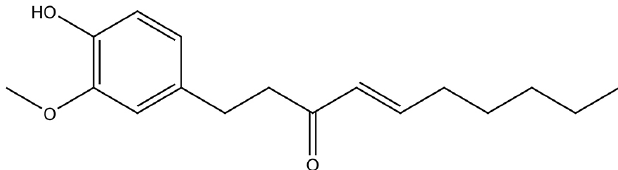
FIGURE 1 - Chemical structure of